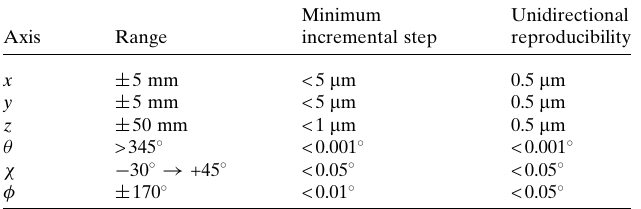
Table 6 List of manipulator motion axes with corresponding motion specifica-